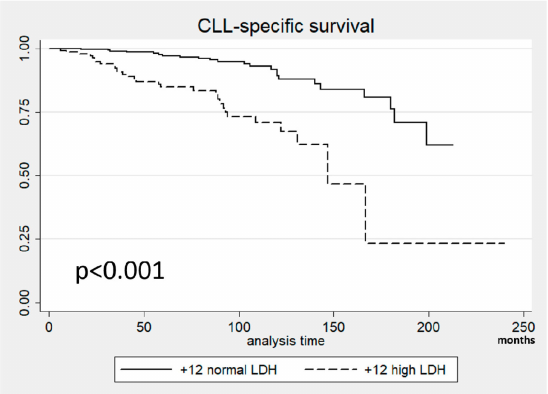
di ff erent rate of CLL-related mortality at 10 years: 29% vs. 11% (Figure 3).